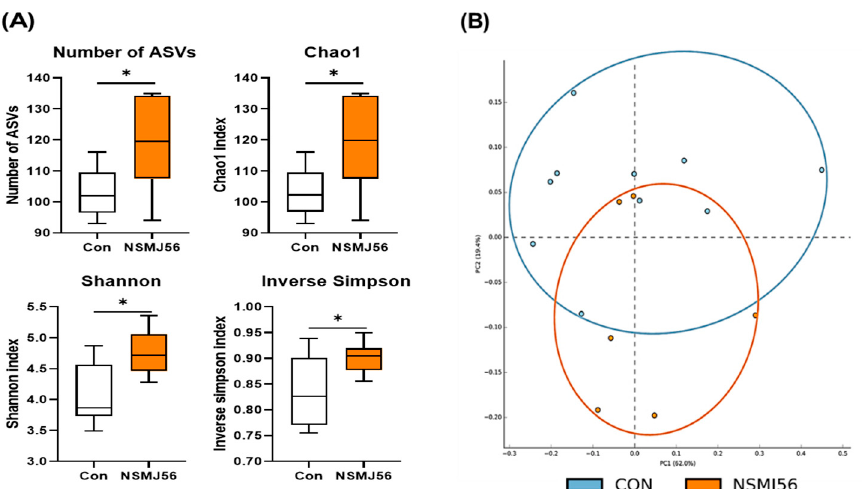
Figure 6. Diversity analysis of the early-age broiler gut microbiome. The alpha diversity and beta diversity of the microbiome in the ceca were compared between the control and NSMJ56 groups at the genus level. Box plots present alpha diversity indices (number of ASVs, Chao1, Shannon, and Inverse Simpson) between the two groups ( A ). Principal coordinate analysis was used for the beta diversity analysis ( B ). Alpha diversity data were obtained from the control group ( n = 10) and NSMJ56 group ( n = 6) and presented as means ± SD. Significant differences between the control and NSMJ56 groups were analyzed by a two-tailed unpaired t -test. * p <